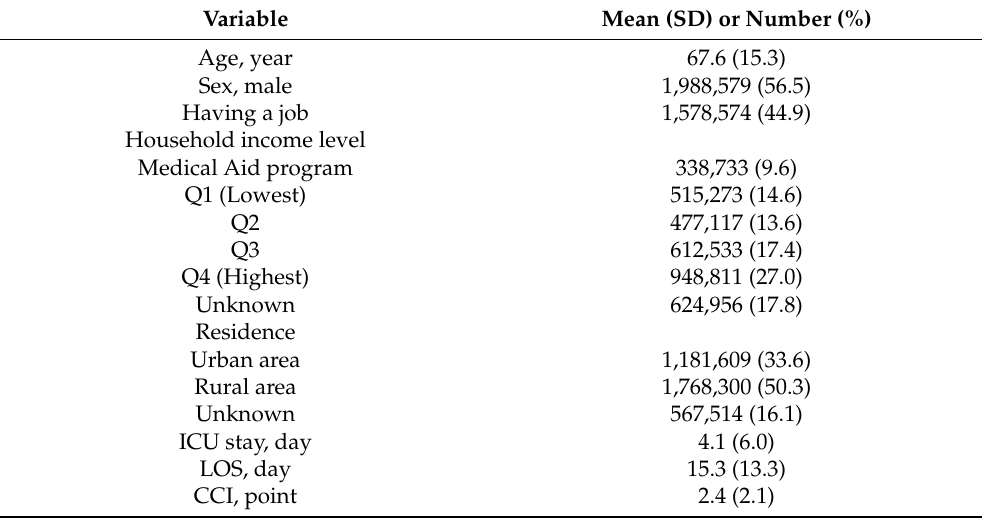
Table 1. Clinicopathological characteristics of the